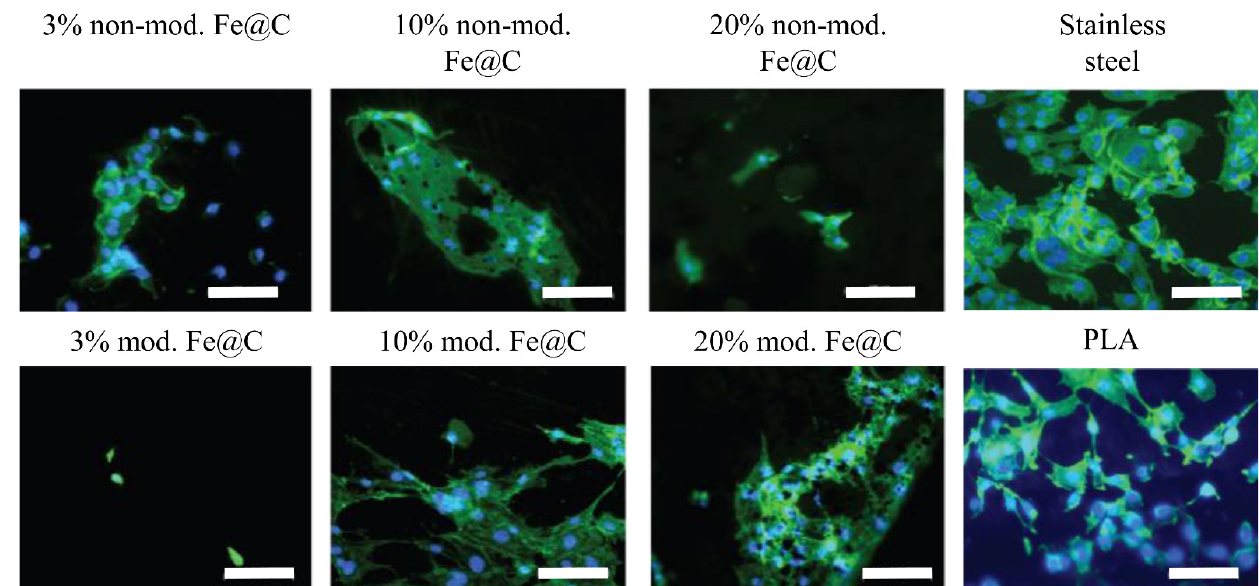
Figure 3. Fluorescent microscopy images of HUVECs after seven days in culture on the surface of PLA coated stainless steel samples with 3%, 10%, and 20% of non-modified and modified Fe@C, as well as directly on stainless steel and plain PLA as references. Scale bar equals 100 µm. Nuclei are stained with DAPI and depicted in blue. Cellular actin skeleton is stained with phalloidin and is visible in green.